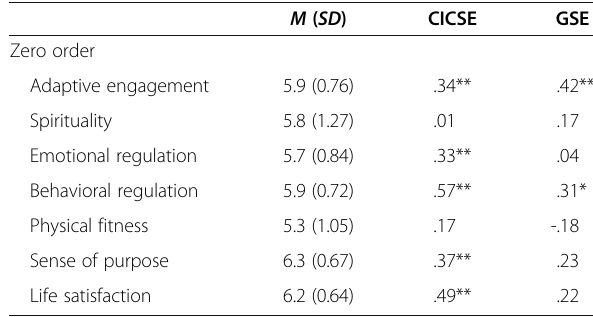
Table 5 Correlations for GSE and CICSE at time 1 with HIRI factors, controlling for years as an aid